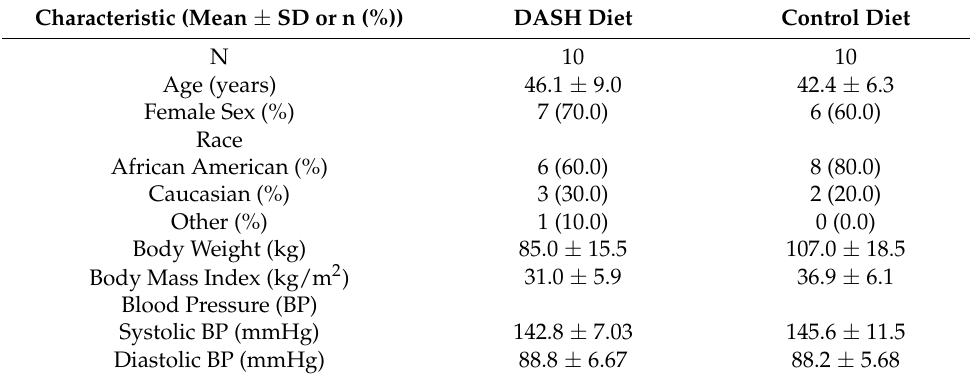
Table 1. Baseline participant characteristics by randomized diet